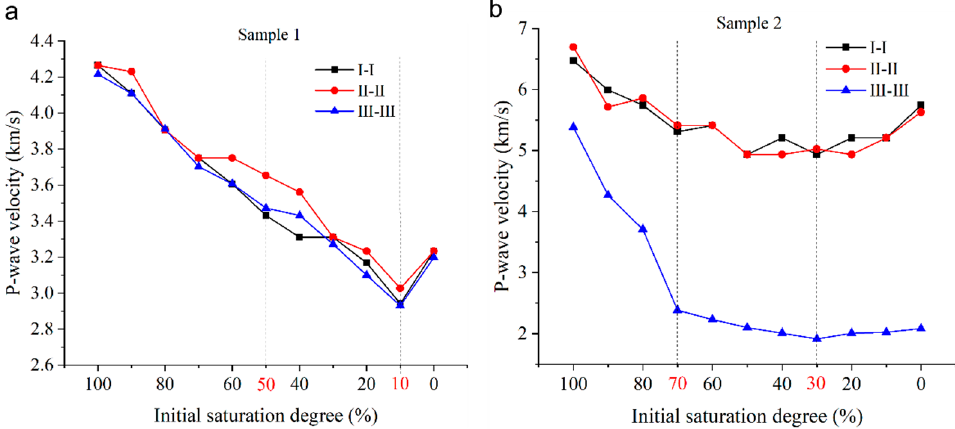
Figure 2. Variations in P-wave velocity with saturation in three directions relative to the bedding plane in samples ( a ) 1 and ( b ) 2.